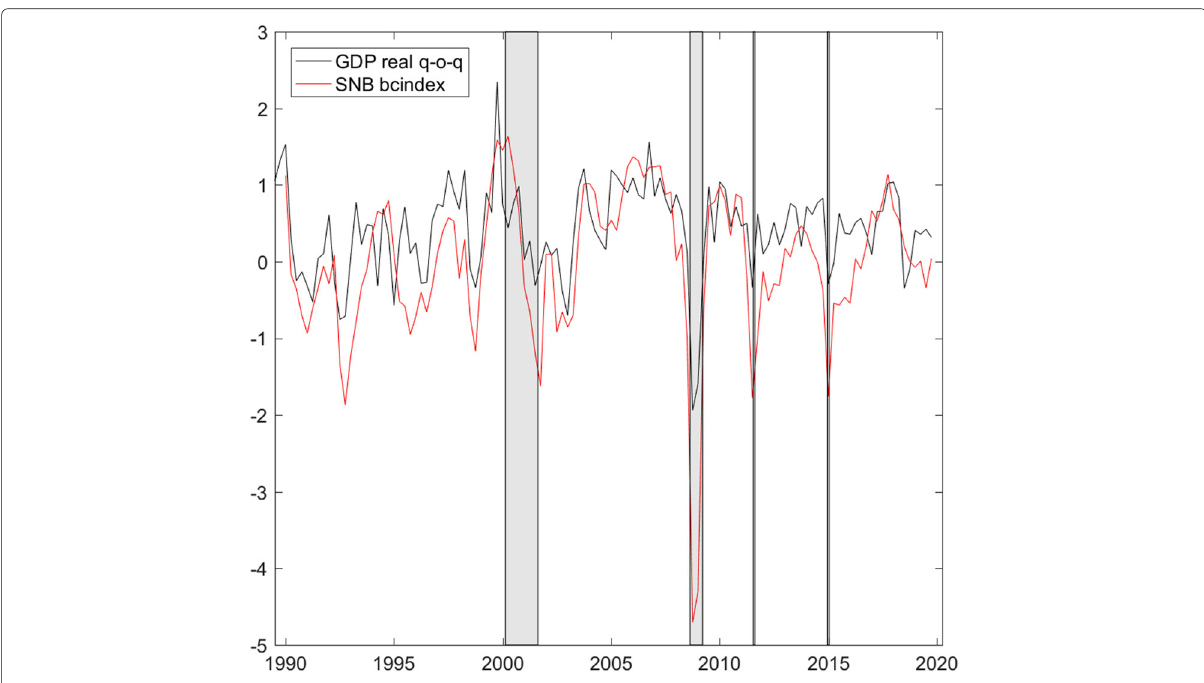
Fig. 3 Growth rates (percentage scale). Real GDP (https://www.seco.admin.ch/seco/de/home/wirtschaftslage---wirtschaftspolitik/Wirtschaftslage/ bip-quartalsschaetzungen-/daten.html, as of March 3, 2020), quarterly frequency, and SNB business cycle index SNB bcindex, (https://data.snb.ch/ de/topics/snb#!/chart/snbbcich, as of April 21, 2020), quarter average of monthly frequency. Gray bars highlight the dotcom and financial crises, the introduction, and discontinuation of the euro-Swiss franc